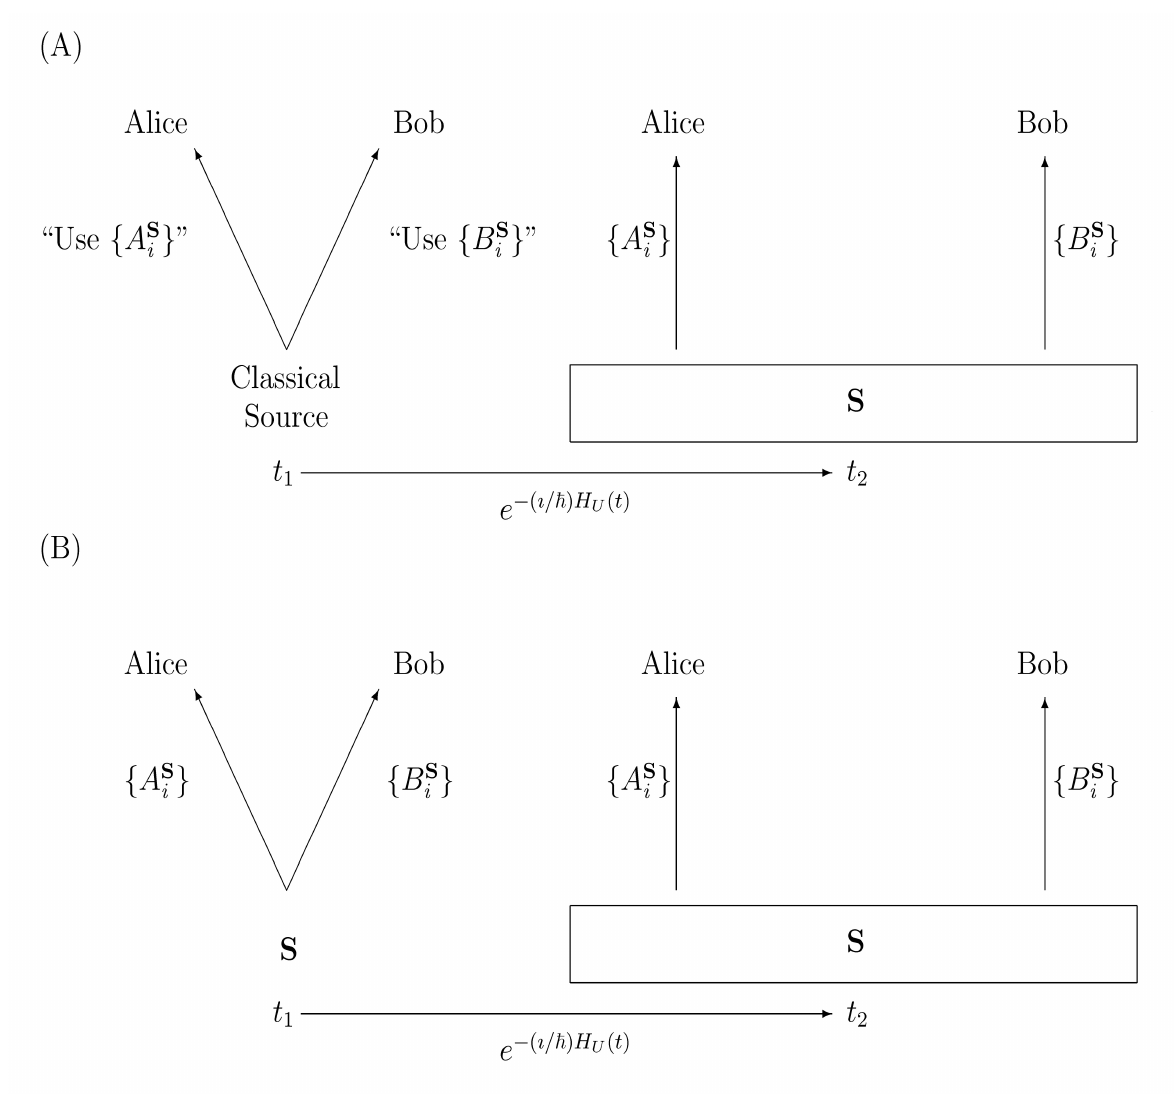
Figure 2. Two options for coordinating the selection of POVMs { A S and Bob, respectively. (A) Alice and Bob receive POVM selection instructions from a classical source. (B) Alice and Bob jointly observe the production of S and agree that their selected POVMs identify